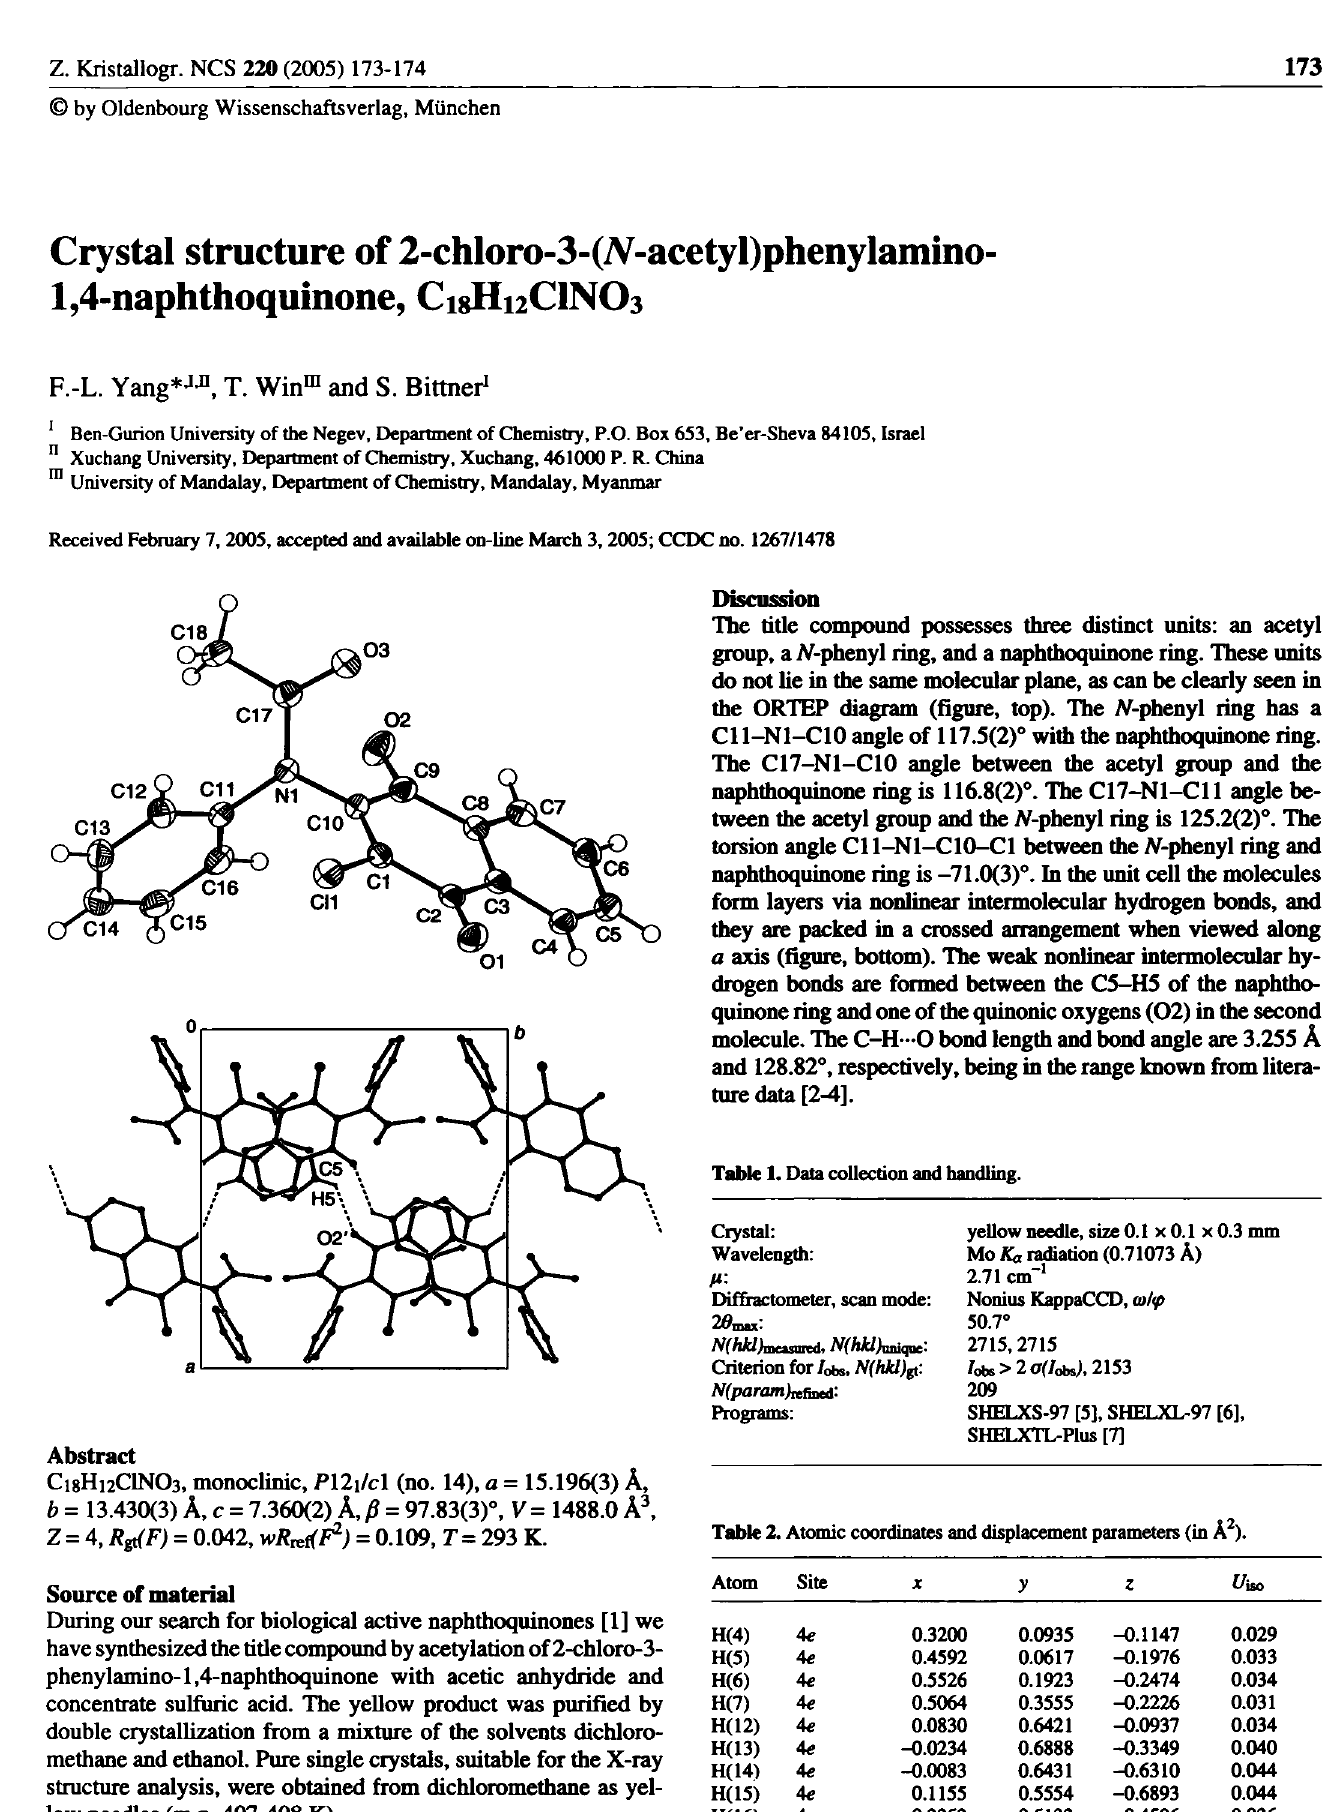
Table 2. Atomic coordinates and displacement parameters (in Ä 2